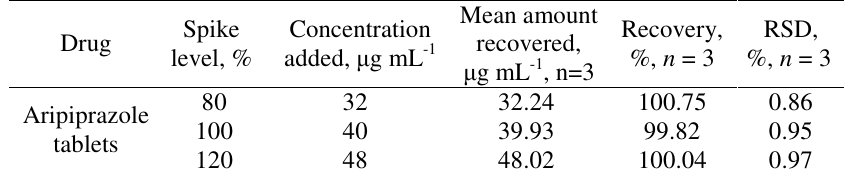
Table 1. Accuracy of the